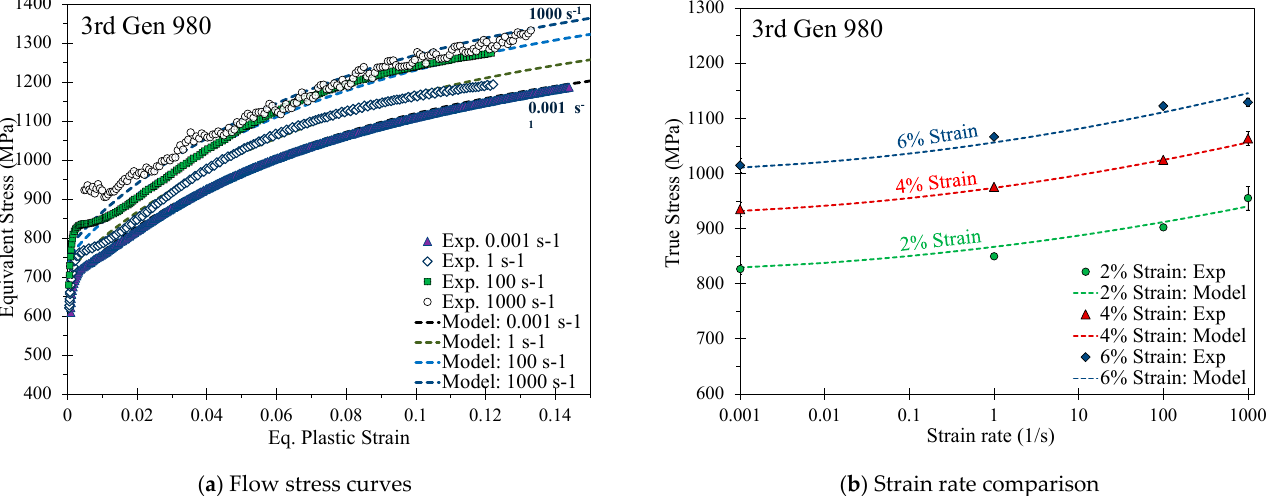
( a ) Flow stress curves ( b ) Strain rate comparison